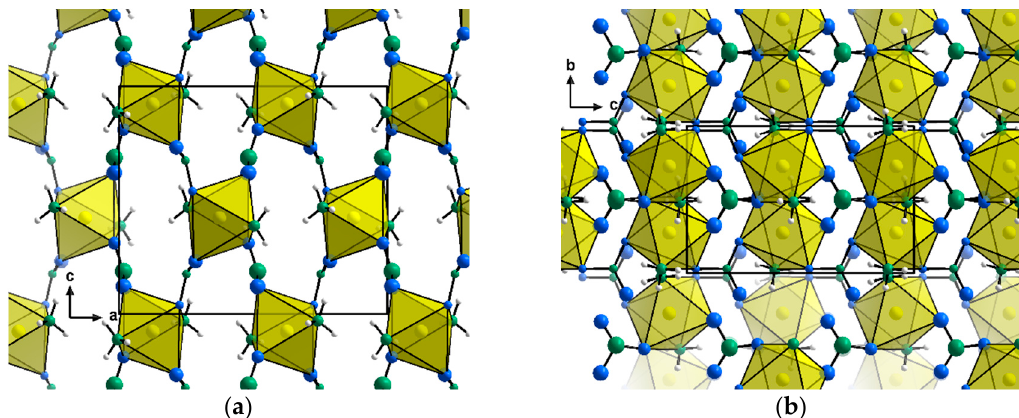
Figure 3. Representation of a unit cell of Ni(NH 3 ) 2 (NO 3 ) 2 along ( a ) the crystallographic b -direction and ( b ) the crystallographic a -direction. Ni (gold), N (green), and O (blue) atoms are represented by their displacement spheres at 90% probability, while H (white) atoms are given as generic balls.